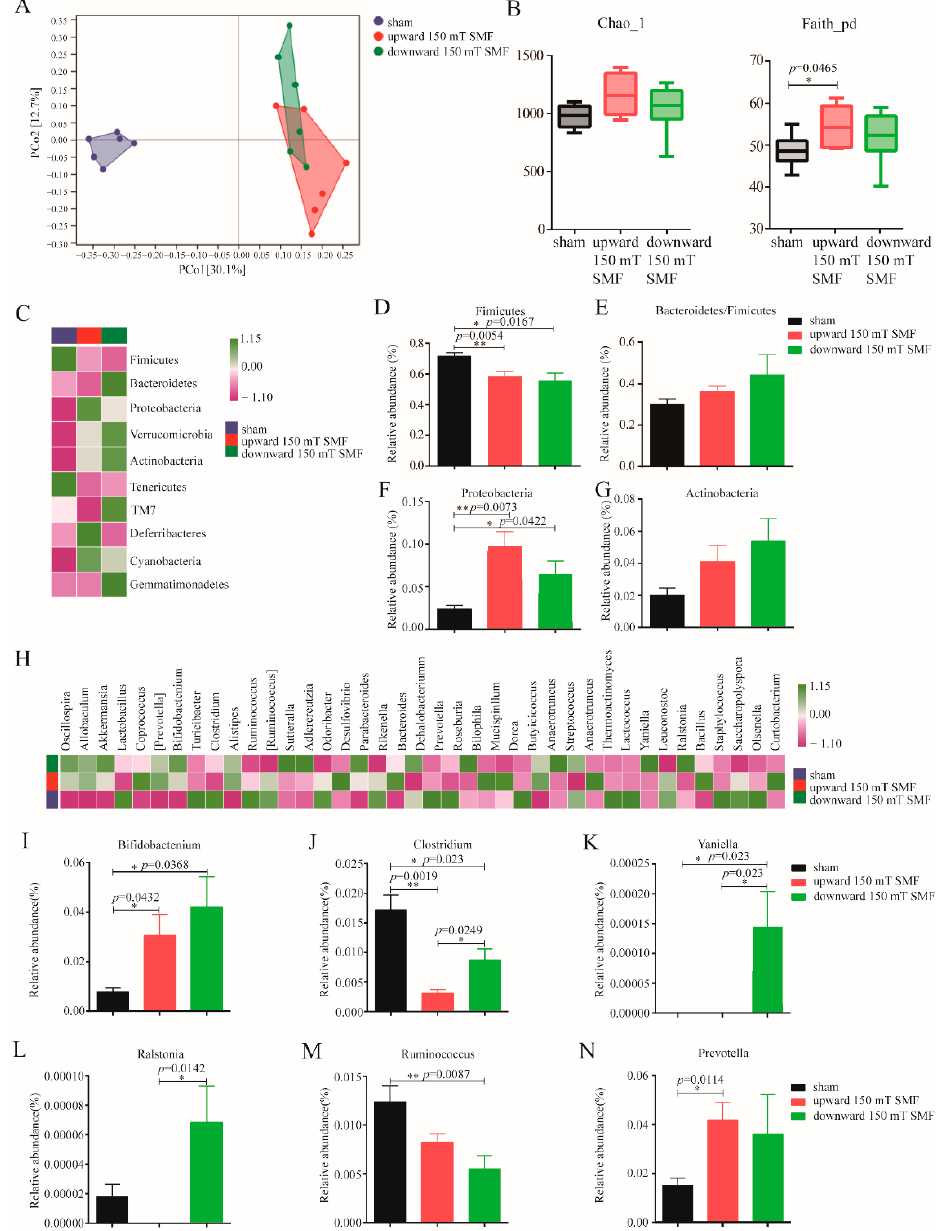
Figure 6. Long-term 150 mT SMF exposure regulated gut microbes’ population in adult female mice. ( A ) Principal coordinates analysis. ( B ) Species richness and diversity analyzed by Chao1 and Faith_pd in mice. ( C ) The taxonomic composition distribution at the phylum level in Top 10 (average value within the group). ( D – G ) The relative abundance of the ratio of Proteobacteria , Actinobacteria , Verrucomicrobia and Bacteroidetes / Firmicutes phyla. ( H ) The taxonomic composition distribution at the genus level in Top 40 (average value within the group). ( I – N ) The relative abundance of generea Bifidobacterium , Clostridiaceae_Clostridium , Yaniella , Ralstonia and Ruminococcus . “*” means p < 0.05 and “**” means p < 0.01.